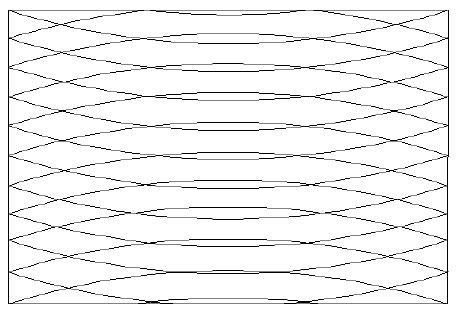
Figure 6. Variable angle layering.